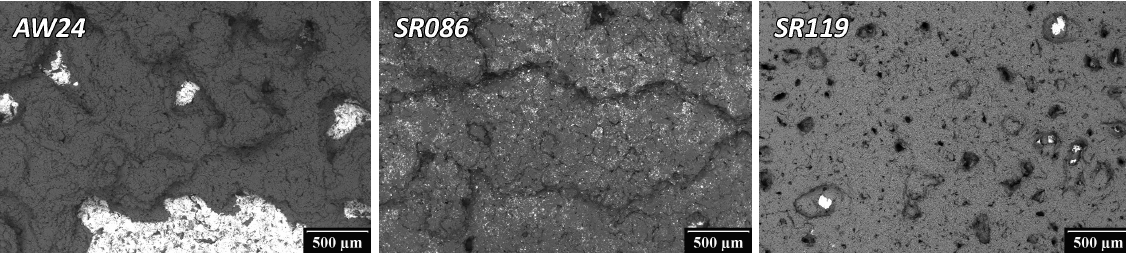
Figure 5. Rim of cavitation crater after the test. Bright spots are the revealed substrate. SEM.